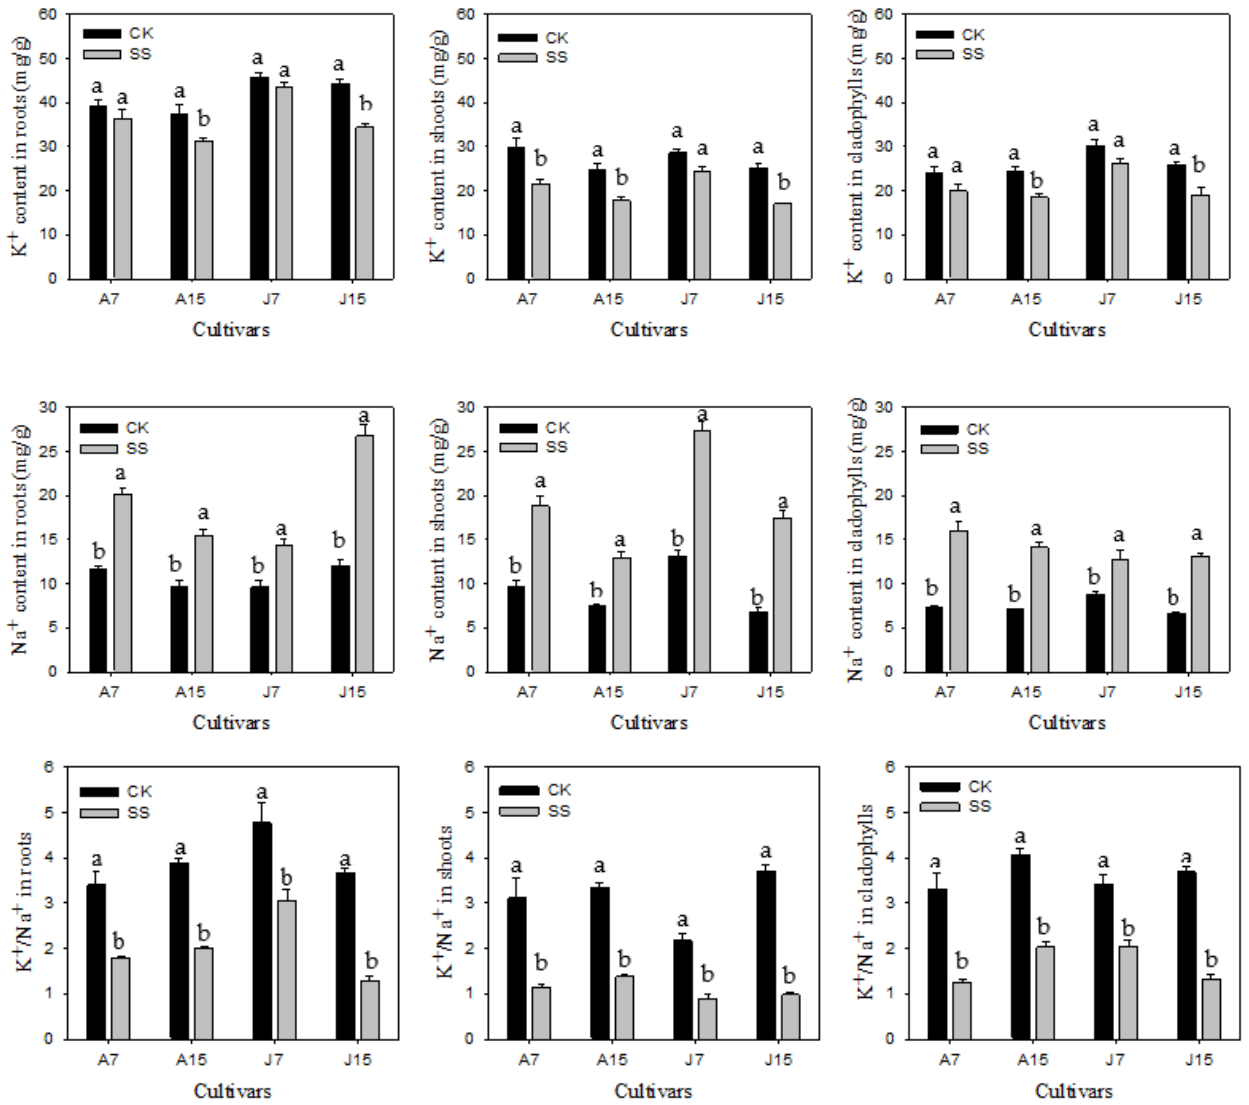
Figure 2. K + , Na + and K + /Na + of two asparagus cultivars under 7 d and 15 d after salt stress. A and J represent Apollo and JL1,7 and 15 mean the days after salt stress, respectively. Different lowercase letters in the bar graph indicate significantly different from the control at p < 0.05. CK, meaning seedlings were watered by Hoagland solution without NaCl, and SS, meaning seedlings were subjected to salt stress of 120 mM